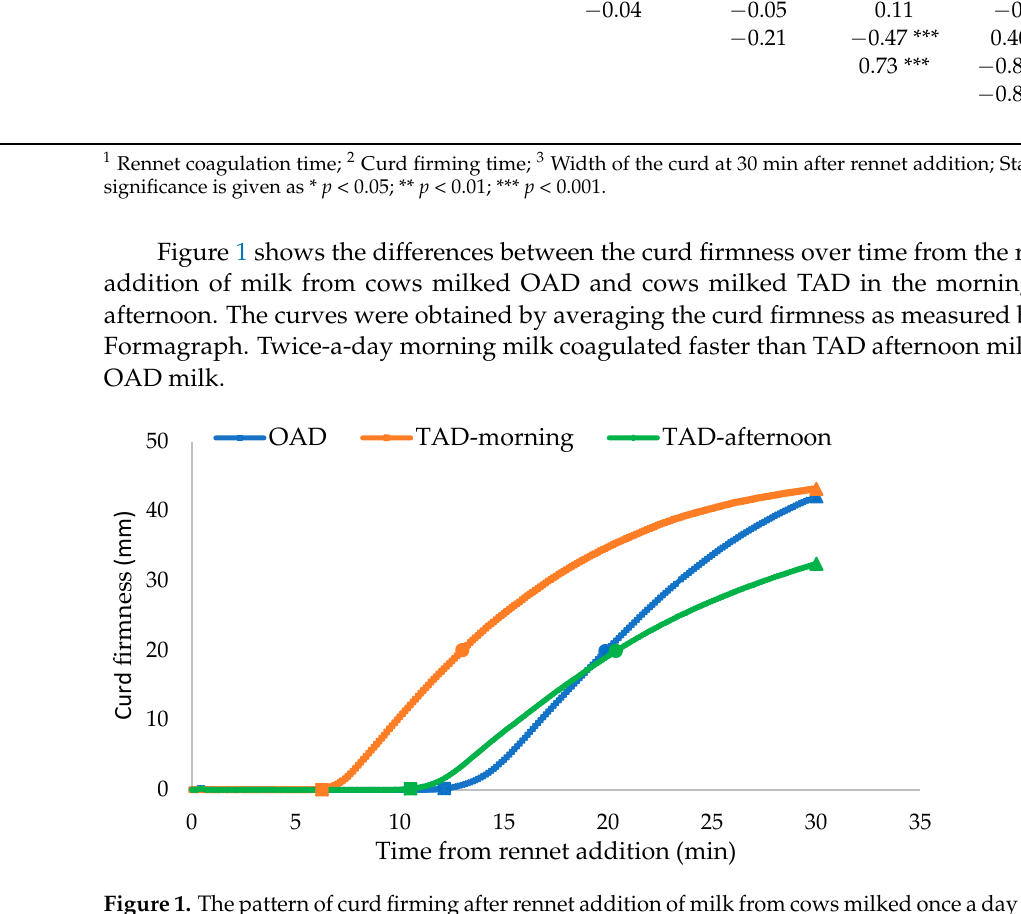
Figure 1. The pattern of curd firming after rennet addition of milk from cows milked once a day (OAD) and twice a day (TAD) (morning and afternoon) in the late lactation in the 2020–2021 production season.